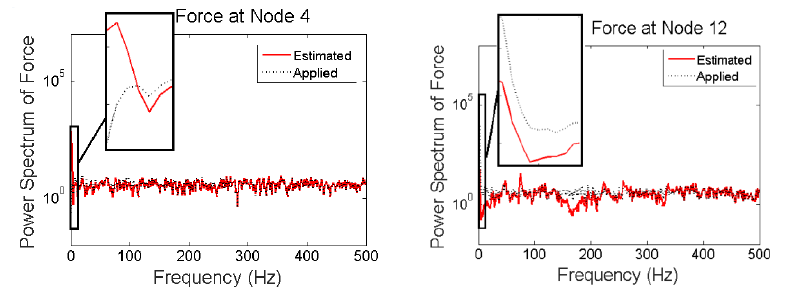
Figure 12. Frequency contents of applied and estimated forces at nodes 4 and 12 for “case